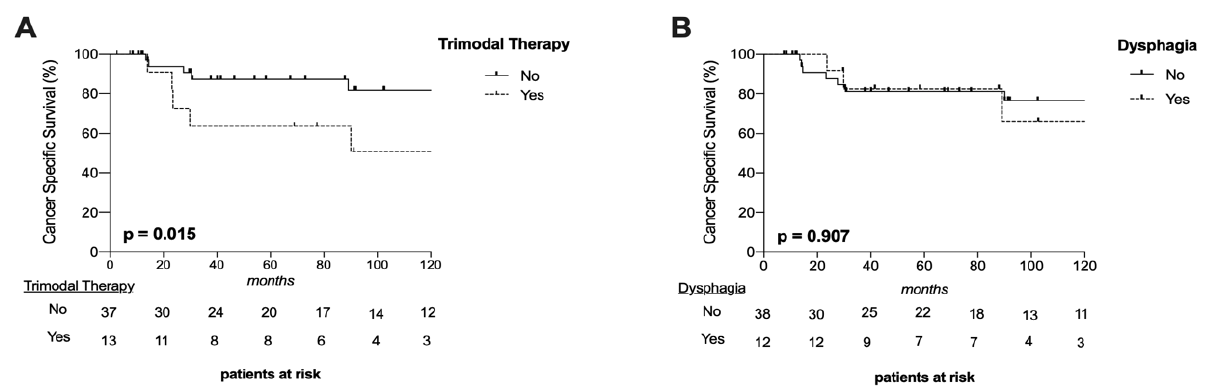
Figure 3. Survival Curves. Cancer-specific survival (CSS) was significantly worse in patients after trimodal therapy (surgery and chemoradiotherapy) ( A ) but not in long-term dysphagic patients ( B ).